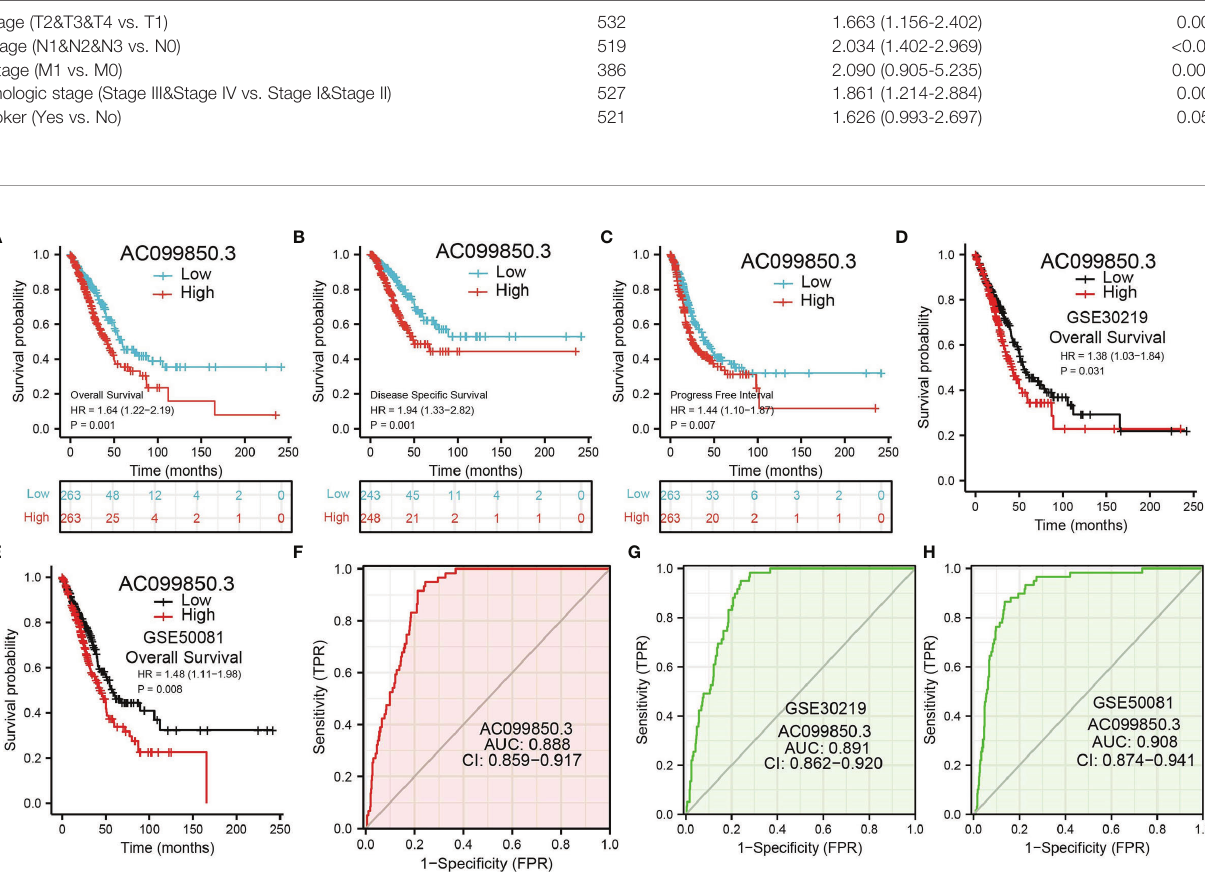
FIGURE 3 | ROC and Kaplan – Meier curves of AC099850.3 (A – C) Kaplan – Meier survival curves showed that LUAD patients with high AC099850.3 expression exhibited poor OS, disease-speci fi c survival, and PFS of AC099850.3 in LUAD determined by TCGA-LUAD dataset. (D, E) Examination of the prognosis values of AC099850.3 in lung cancer by GEO datasets. (F – H) ROC curves were used to determine the diagnostic value of AC099850.3 in